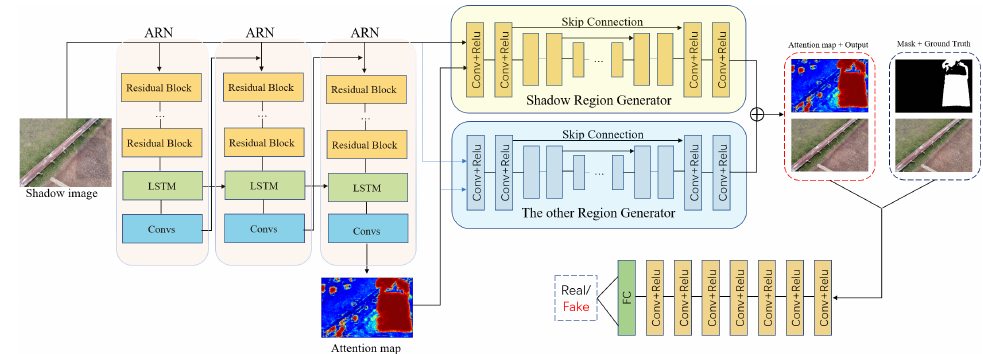
Figure 3. The architecture of our proposed network. The generator consists of an Attentive Recurrent Network (ARN) and two contextual autoencoders. The discriminator contains seven convolution layers and a fully connected